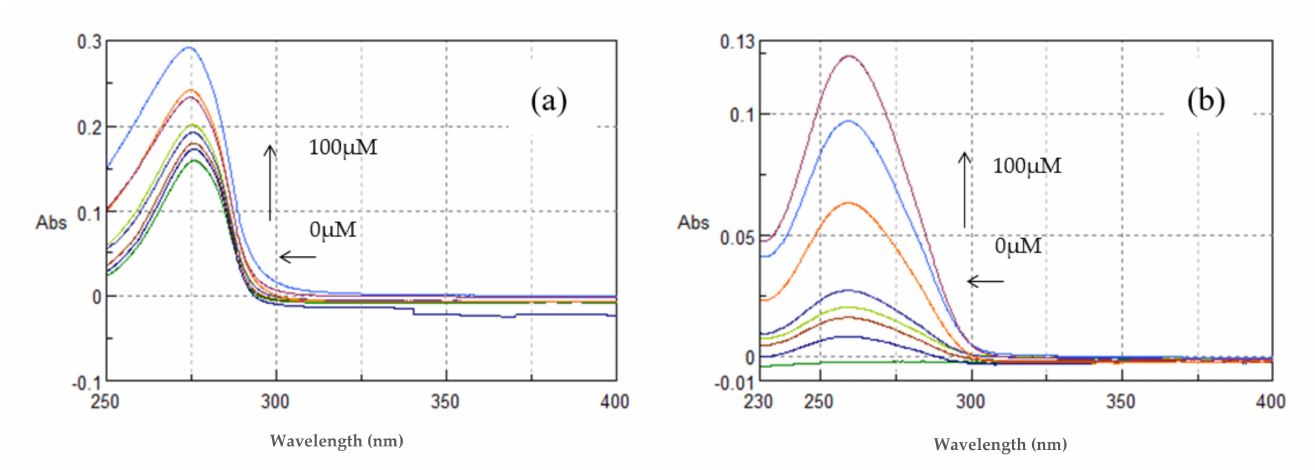
Figure 13. Absorption spectra of ( a ) TYR and ( b ) β CD (100 µ M, pH 7.4) in Tris-HCl buffer with increasing concentrations of ctDNA (0–100 µ M). Arrows ( ) and ( ) refer to hyperchromic and hypochromic (blue shift) effects,